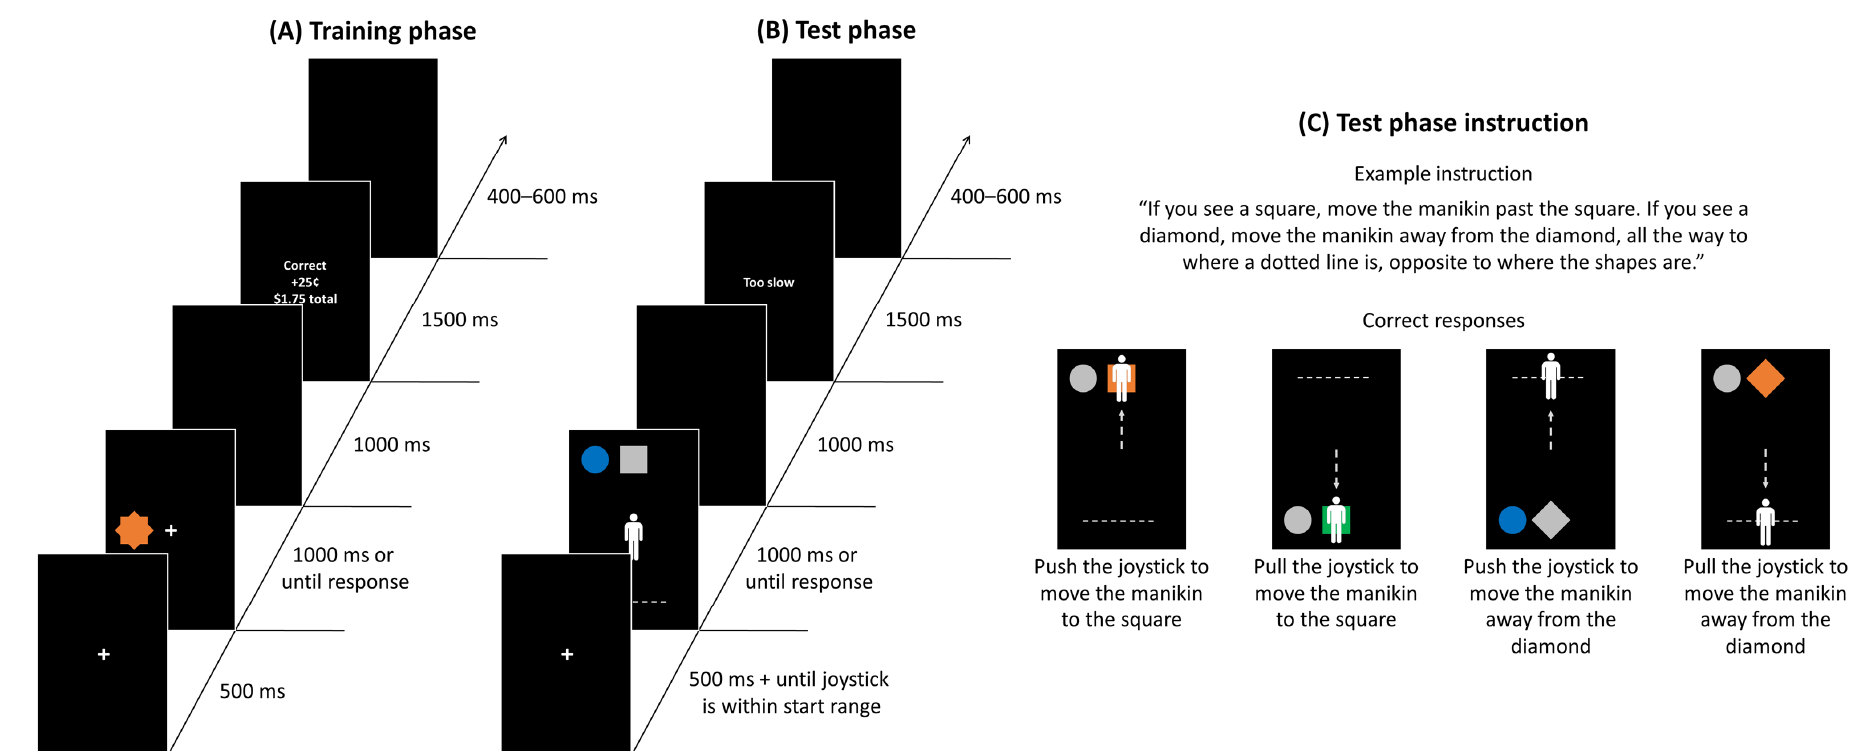
Figure 3. Sequence of trial events for the ( A ) training and ( B ) test phases in Experiment 2. ( C ) Test phase example instruction and correct responses that correspond to the instruction. The vertical dotted line with an arrow depicts the movement of the manikin resulting from the correct joystick action and is for illustration purposes (did not actually appear in the experiment).